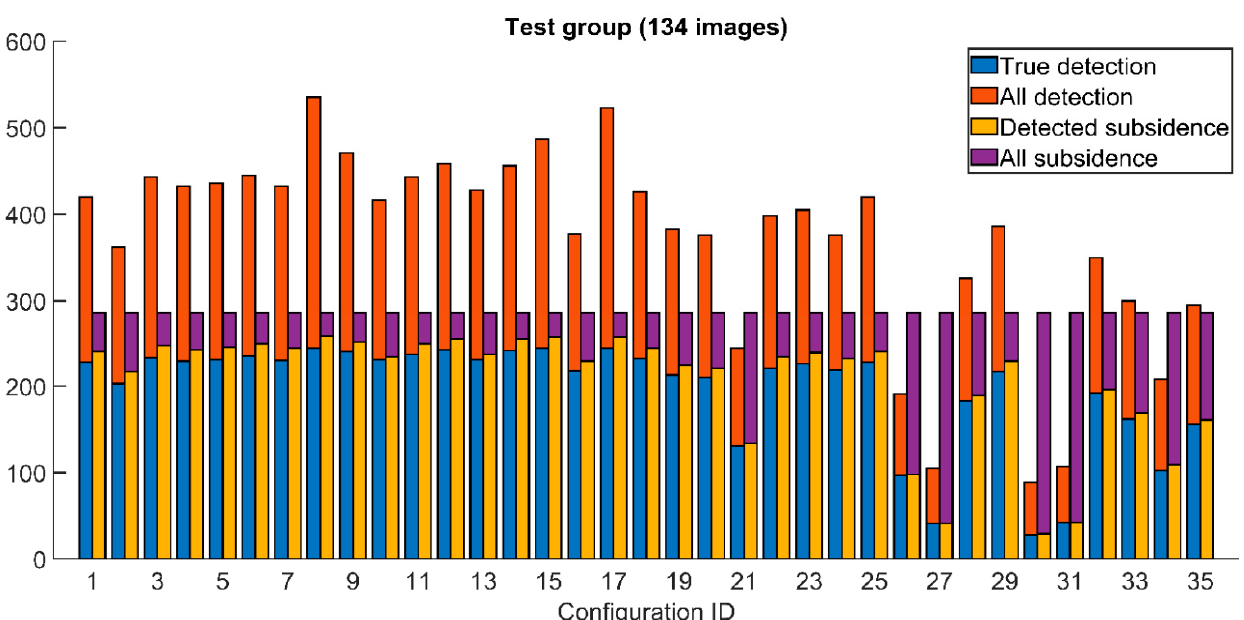
Figure 5. Efficiency of the trough detection algorithm for the 134-element test set for all 35 combinations of parameter values (Table 1).